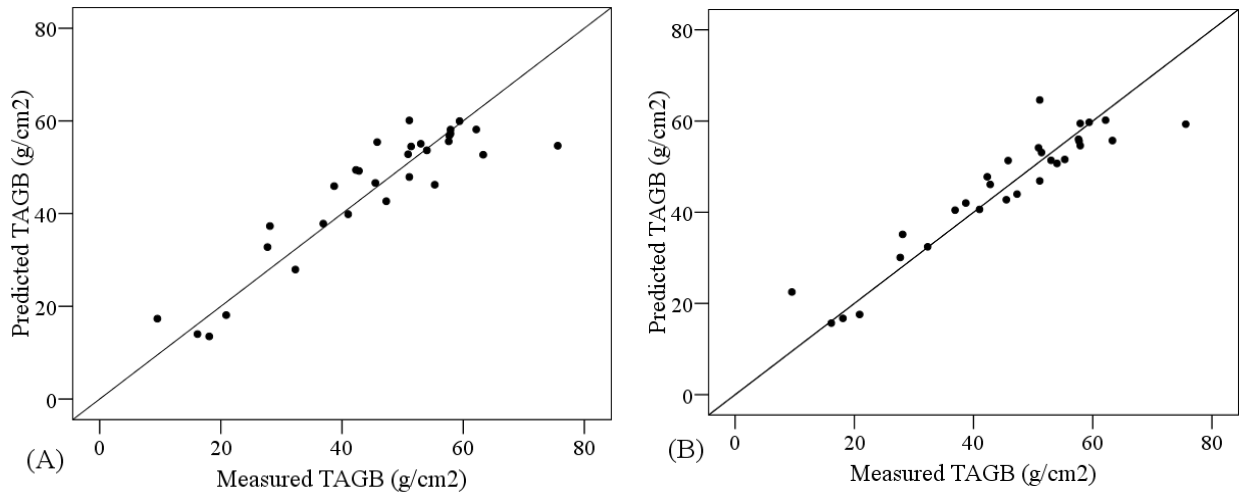
Figure 4. Cross-calibration results for TAGB using ( A ) PLSR based on the continuum-removed MBD index and ( B ) SVM based on non-transformed VNIR + SWIR1 data. One-to-one line is